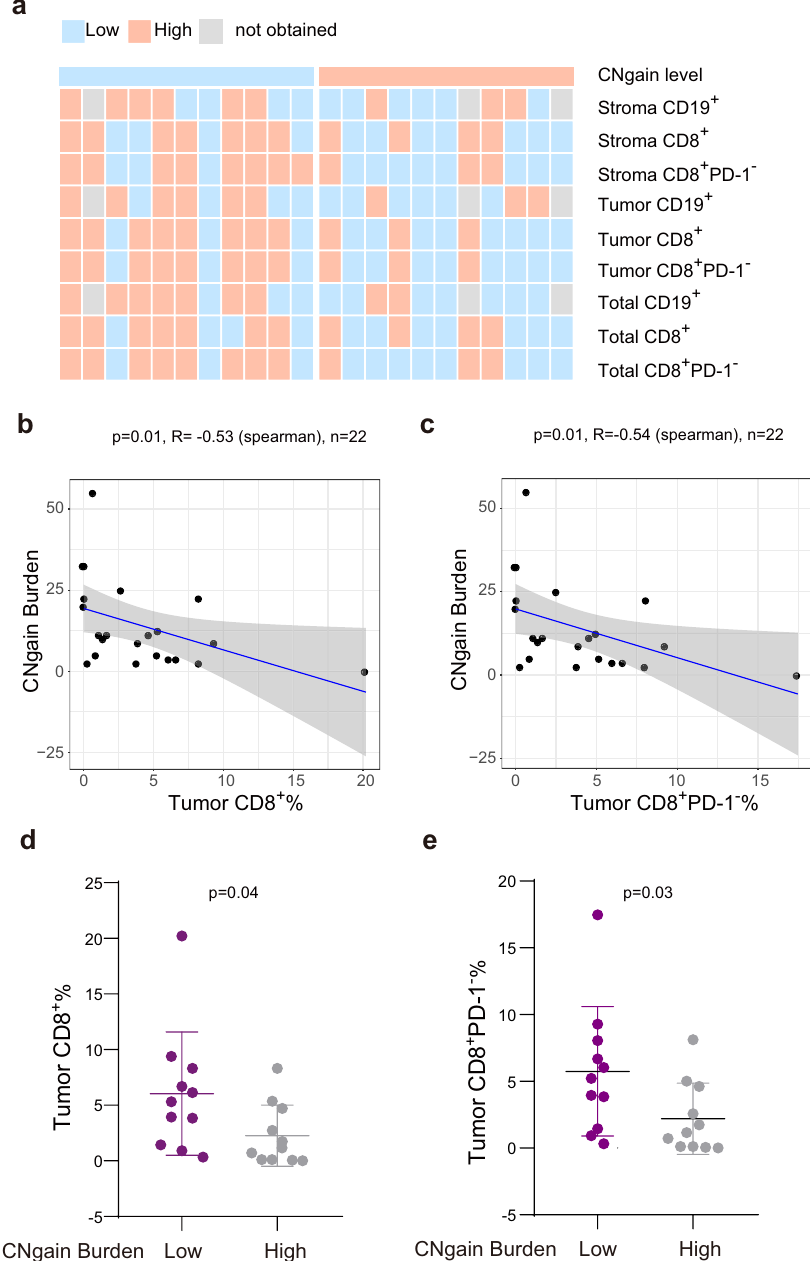
Fig. 3 The negative correlation between CNgain burden and CD8 + cells enrichment in pre-treatment tumors. a Heatmap shows the distribution of indicated high and low lymphocytes in pre-treatment tumors of two groups with high or low CNgain burden. b , c The correlation between CNgain burden and CD8 + ( b )/CD8 + PD-1 − ( c ) T cells in tumor region of the pre-treatment samples (p < 0.05, Spearman ’ s correlation). d , e The comparison of CD8 + ( d ) / CD8 + PD-1 − ( e ) T cells in CNgain low and high groups (p < 0.05, Mann – Whitney U